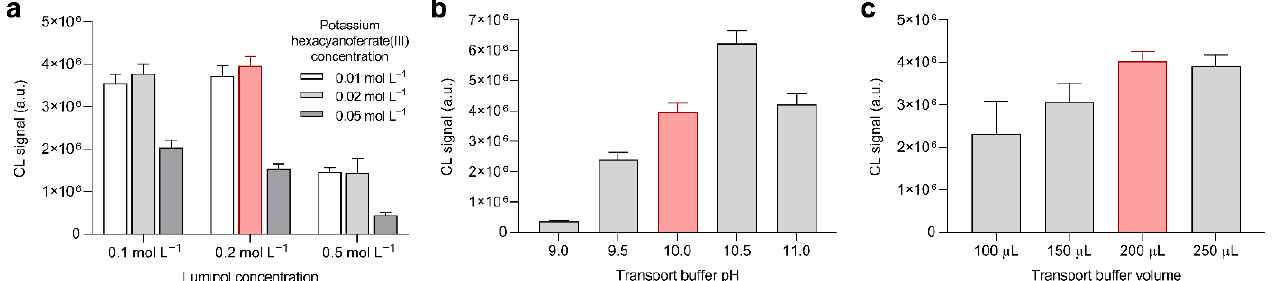
Figure 3. Optimization of experimental conditions for hydrogen peroxide detection, performed by analyzing 10 µ L of a 100 µ mol L − 1 hydrogen peroxide standard solution (the selected conditions are highlighted). ( a ) CL signals obtained in origami µ PADs containing different amounts of luminol and potassium hexacyanoferrate(III); ( b ) CL signals obtained with carbonate transport buffers at different pH; ( c ) CL signals obtained using different carbonate transport buffer volumes. In each measurement, the optimal values for the other experimental conditions were used. Each value is the mean ± SD of six measures performed in three origami µPADs.